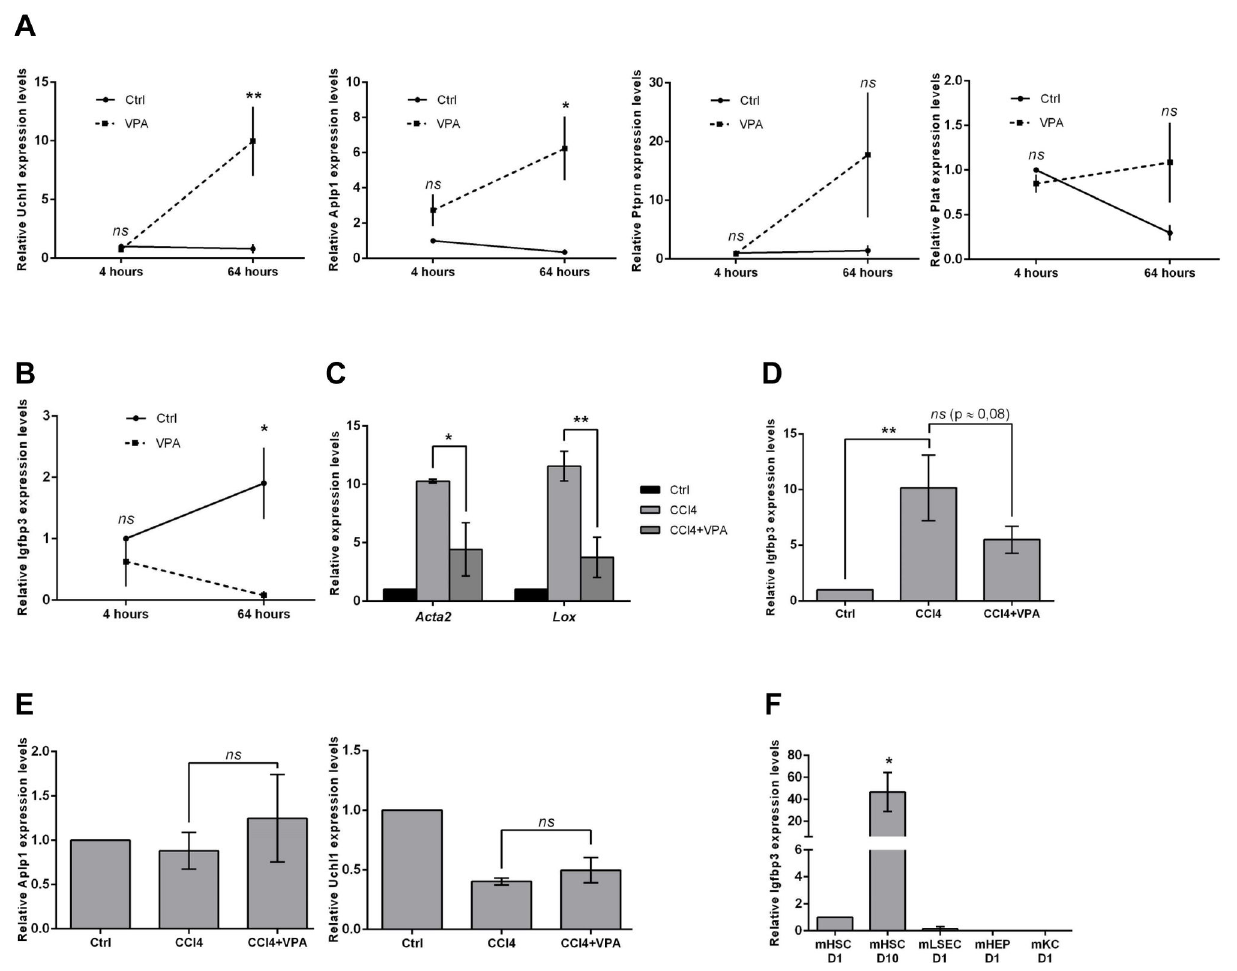
Figure 4. Validation of VPA-dependent genes during HSC activation in vitro and in vivo . ( A , B ) mRNA levels of Uchl1 , Aplp1 , Prtpn, Plat and Igfbp3 in in vitro activating HSCs cultured for 4 or 64 hours with or without VPA supplementation determined by qPCR. n=3 ( C ) mRNA expression of HSC activation markers Acta2 and Lox in HSCs isolated from CCl treated mice , ( D ) Uchl1 , 4 Aplp1 and Igfbp3 mRNA levels in in vivo activated hepatic stellate cells (HSCs). The cells were isolated from Balb/C jicco CBY mice that were treated for 2 weeks with CCl with or without VPA supplementation to the drinking water. ( E ) Different liver cell types were 4 isolated from healthy mouse livers; hepatocytes were obtained with Percoll gradients, HSCs with Nycodenz gradients and KC